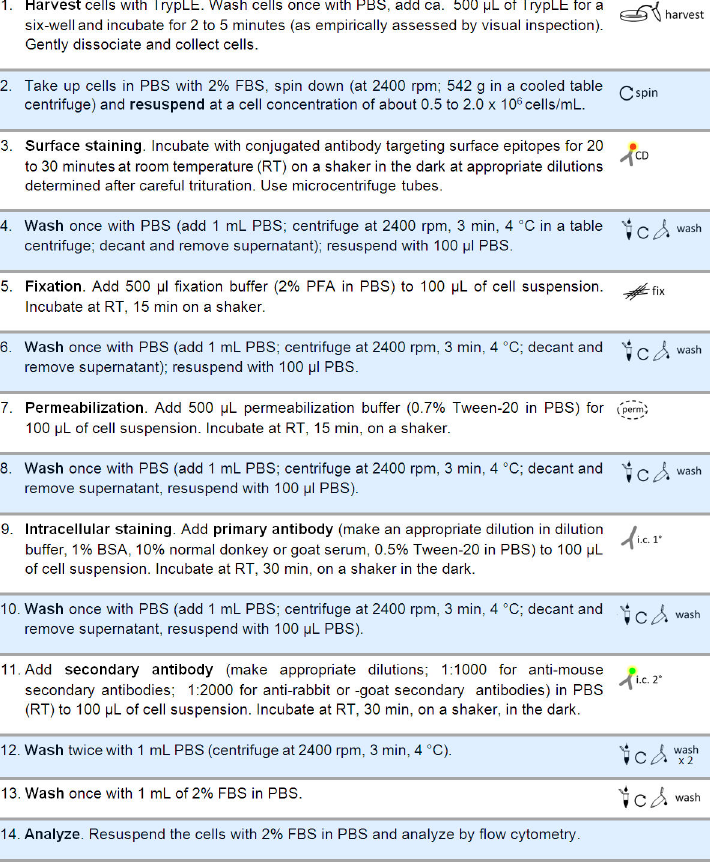
Figure 4. Optimized protocol. The detailed list of steps illustrates the working protocol for combined surface and intracellular epitope staining of mammalian cells for flow cytometric analysis. See methods section for further details on reagents and